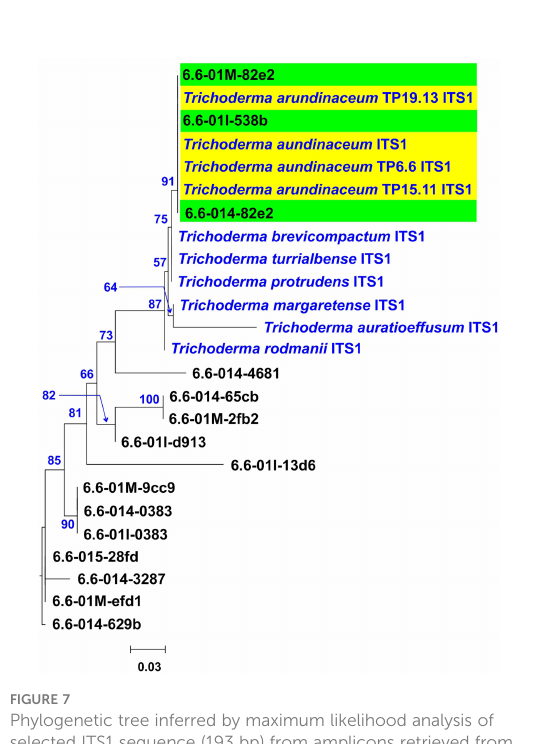
FIGURE 7 Phylogenetic tree inferred by maximum likelihood analysis of selected ITS1 sequence (193 bp) from amplicons retrieved from the microbiome analysis (black type, 6.6-01#) and Trichoderma species in the Brevicompactum clade (blue type sequences), The amplicon sequences selected for this analysis were those with the highest scores in BLASTn analysis in which the ITS1 sequence from the T. arundinaceum reference strain IBT 40837 was queried against all ITS1 amplicon sequences derived from four soil samples collected from Plot 6. Numbers near each branch (blue type) are bootstrap values based on 1,000 pseudoreplicates. Yellow rectangle denotes sequences of the three T. arundinaceum strains isolated in the current study and the reference strain IBT 40837. Green rectangles denote amplicon sequences that are identical to ITS1 from reference strain IBT 40837.